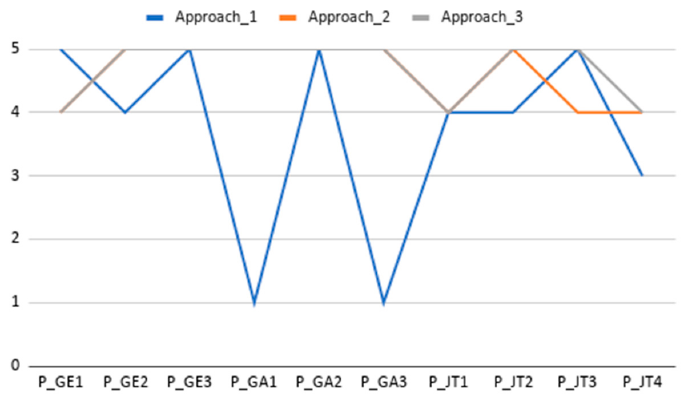
Figure 21. OBINTER Approach-related specific statement assessment results per participant. Line chart shows the score achieved in each question for each participant, where 1 = ‘Strongly Disagree’ and 5 = ‘Strongly Agree’.